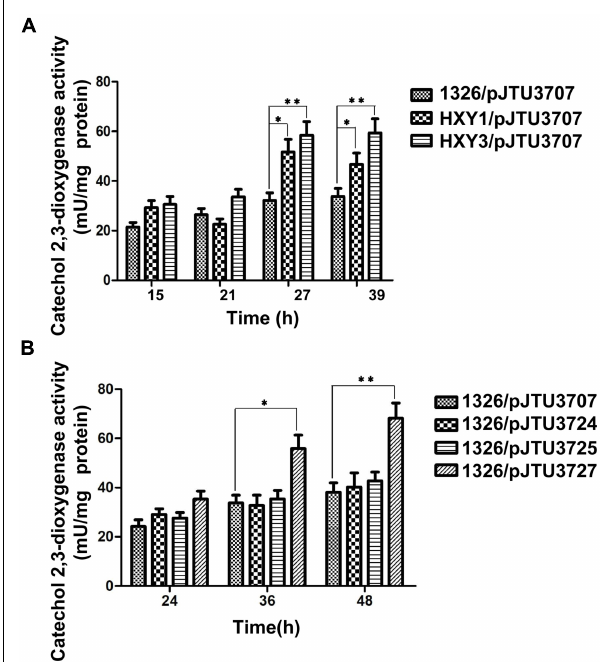
FIGURE 3 | The effects of S9 and S12 sulfur-modified sites on dndB transcription . (A) Histogram showing assays of quantitative catechol 2,3-dioxygenase activity from 1326/pJTU3707, HXY1/pJTU3707, and HXY3/pJTU3707. HXY1, 1326 derivative with dndA deleted; HXY3, 1326 derivative with dndC deleted. (B) Histogram showing assays of quantitative catechol 2,3-dioxygenase activity from 1326/pJTU3707, 1326/pJTU3724, 1326/pJTU3725, and 1326/pJTU3727. pJTU3724, pJTU3707 derivative with single mutation in S9 site; pJTU3727, pJTU3707 derivative with double mutations in S9 and S12 sites. ∗ P < 0.05; ∗∗ P < 0.01. Three replicates were performed.